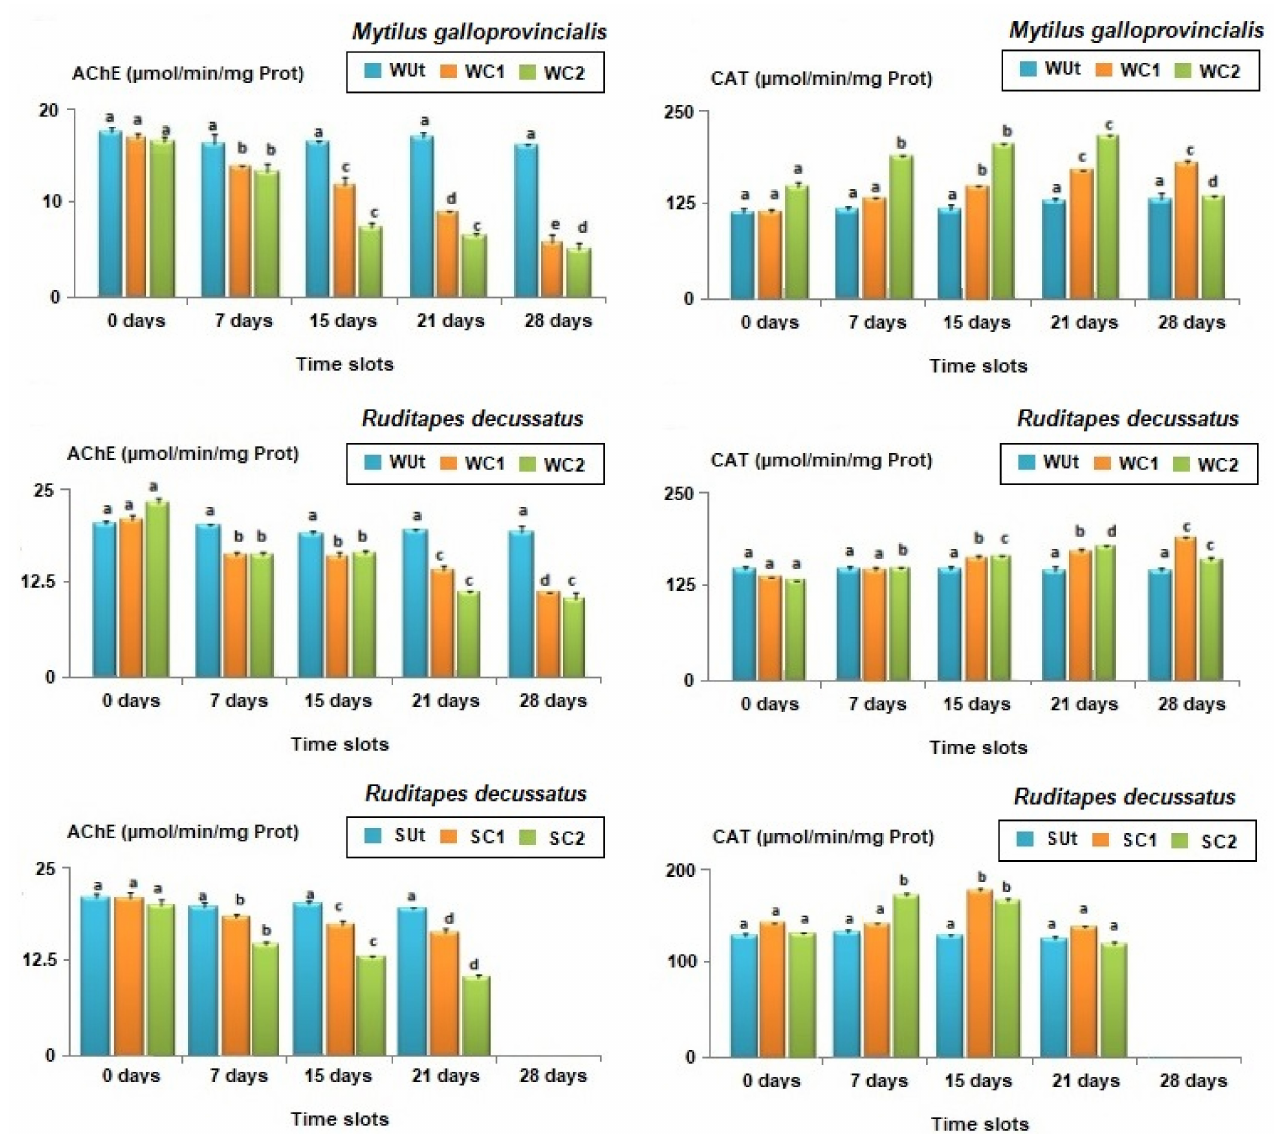
Figure 5. Average biomarker responses ( ± standard deviation) in bivalves’ species Mytilus galloprovin- cialis and Ruditapes decussatus after exposure to an Untreated control (Ut) and two concentrations of phenanthrene in water [50 µ g/L (WC1) and 100 µ g/L (WC2)] and sediment [50 µ g/kg (SC1) and 100 µ g/kg (SC2)] over 28 days. Catalase (CAT); Acetylcholinesterase (AChE). Different letters (a, b,